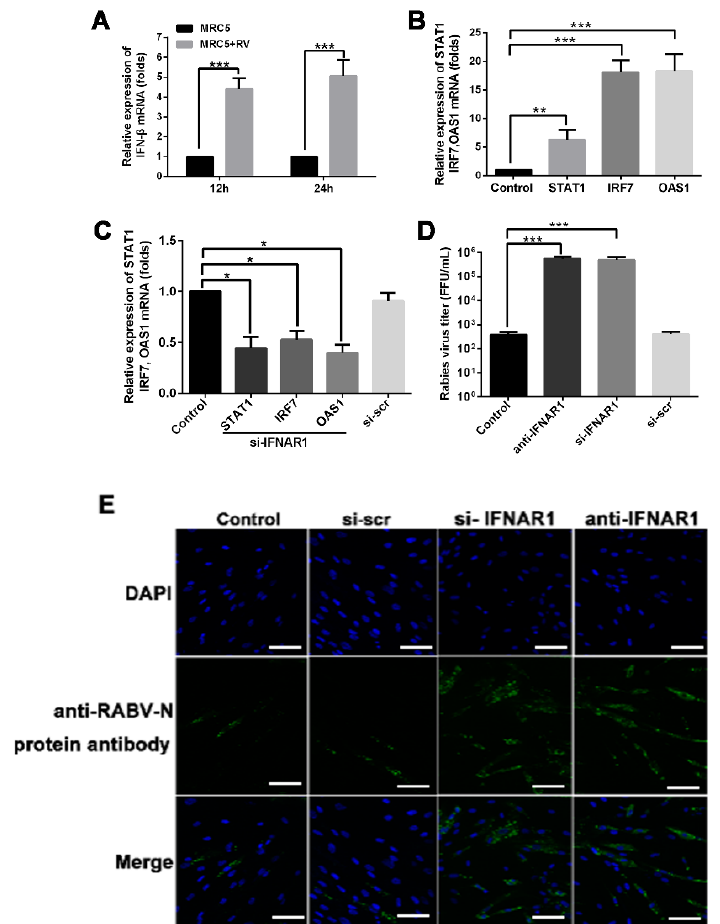
Figure 5. Rabies virus (RABV) infection induces up-regulation of interferon (IFN)- β in MRC-5 cells. ( A ) MRC-5 cells were infected with RABV (multiplicity of infection (MOI) = 0.1) for 12 h or 24 h. IFN- β expression was measured by quantitative reverse transcriptase PCR (qRT-PCR). ( B ) MRC-5 cells were infected with RABV (MOI = 0.1) for 24 h, and the expression levels of STAT1 , IRF7 , and OAS1 were determined by qRT-PCR. ( C ) MRC-5 cells were transfected with 100 nmol/L an siRNA targeting IFNAR1 or an siRNA negative control (si-scr), and infected with RABV at 24 h post transfection. Total RNA was extracted 24 h post infection, and the expression levels of the mRNAs encoding the JAK-STAT pathway proteins of STAT1, IRF7, and OAS1 were determined using qRT-PCR. ( D ) MRC-5 cells were treated with 100 nmol/L of an siRNA targeting IFNAR1 (si-IFNAR1) for 24 h or 10 µg/mL of an anti-IFNAR monoclonal antibody for 6 h. After the change of culture media, the MRC-5 cells were infected with RABV (MOI = 0.1). At 48 h post infection, the RABV titers in cell supernatants were determined using qRT-PCR. ( E ) MRC-5 cells were treated with 100 nmol/L of an siRNA targeting IFNAR1 (si-IFNAR1) for 24 h or 10 µg/mL of an anti-IFNAR monoclonal antibody for 6 h. After the change of culture media, MRC-5 cells were infected with RABV (MOI = 0.1). At 12 h post infection, the cells were incubated with fluorescein isothiocyanate-labeled RABV N protein antibody (green) for 2 h, and the cell nuclei were stained with 4 ′ ,6-diamidino-2-phenylindole (blue). Scale bar = 50 µm. Three independent experiments were performed. *, **, and *** indicate p < 0.05, p < 0.01, and p < 0.001, respectively.